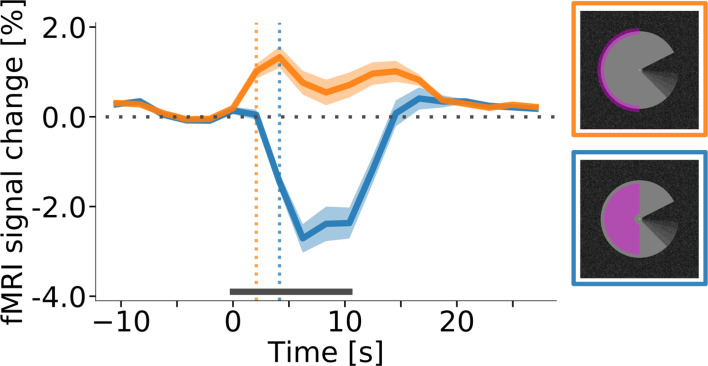
Response onset times in V1.(A) Event-related fMRI timecourses for regions of interest corresponding to the stimulus centre (blue line) and the edge of the stimulus (orange line). The dotted vertical lines indicate the response onset, defined as the first time point at which the signal was significantly different from zero (one-sample t-test, p<0.05, Bonferroni corrected). The positive response at the stimulus edge precedes the negative response at the stimulus centre by one volume (i.e. by about 2 s), suggesting that the negative response is not caused by the onset of the stimulus, but by its prolonged presentation. The response is shown for area V1 of the right hemisphere, averaged (mean) over subjects, stimulus conditions, and cortical depth levels. The horizontal grey bar marks the duration of the stimulus block. Error shading represents the standard error of the mean (across subjects). (See Figure 5—figure supplement 1 for same results separately for all areas and conditions, and Figure 5—figure supplement 2 for single-subject data.).